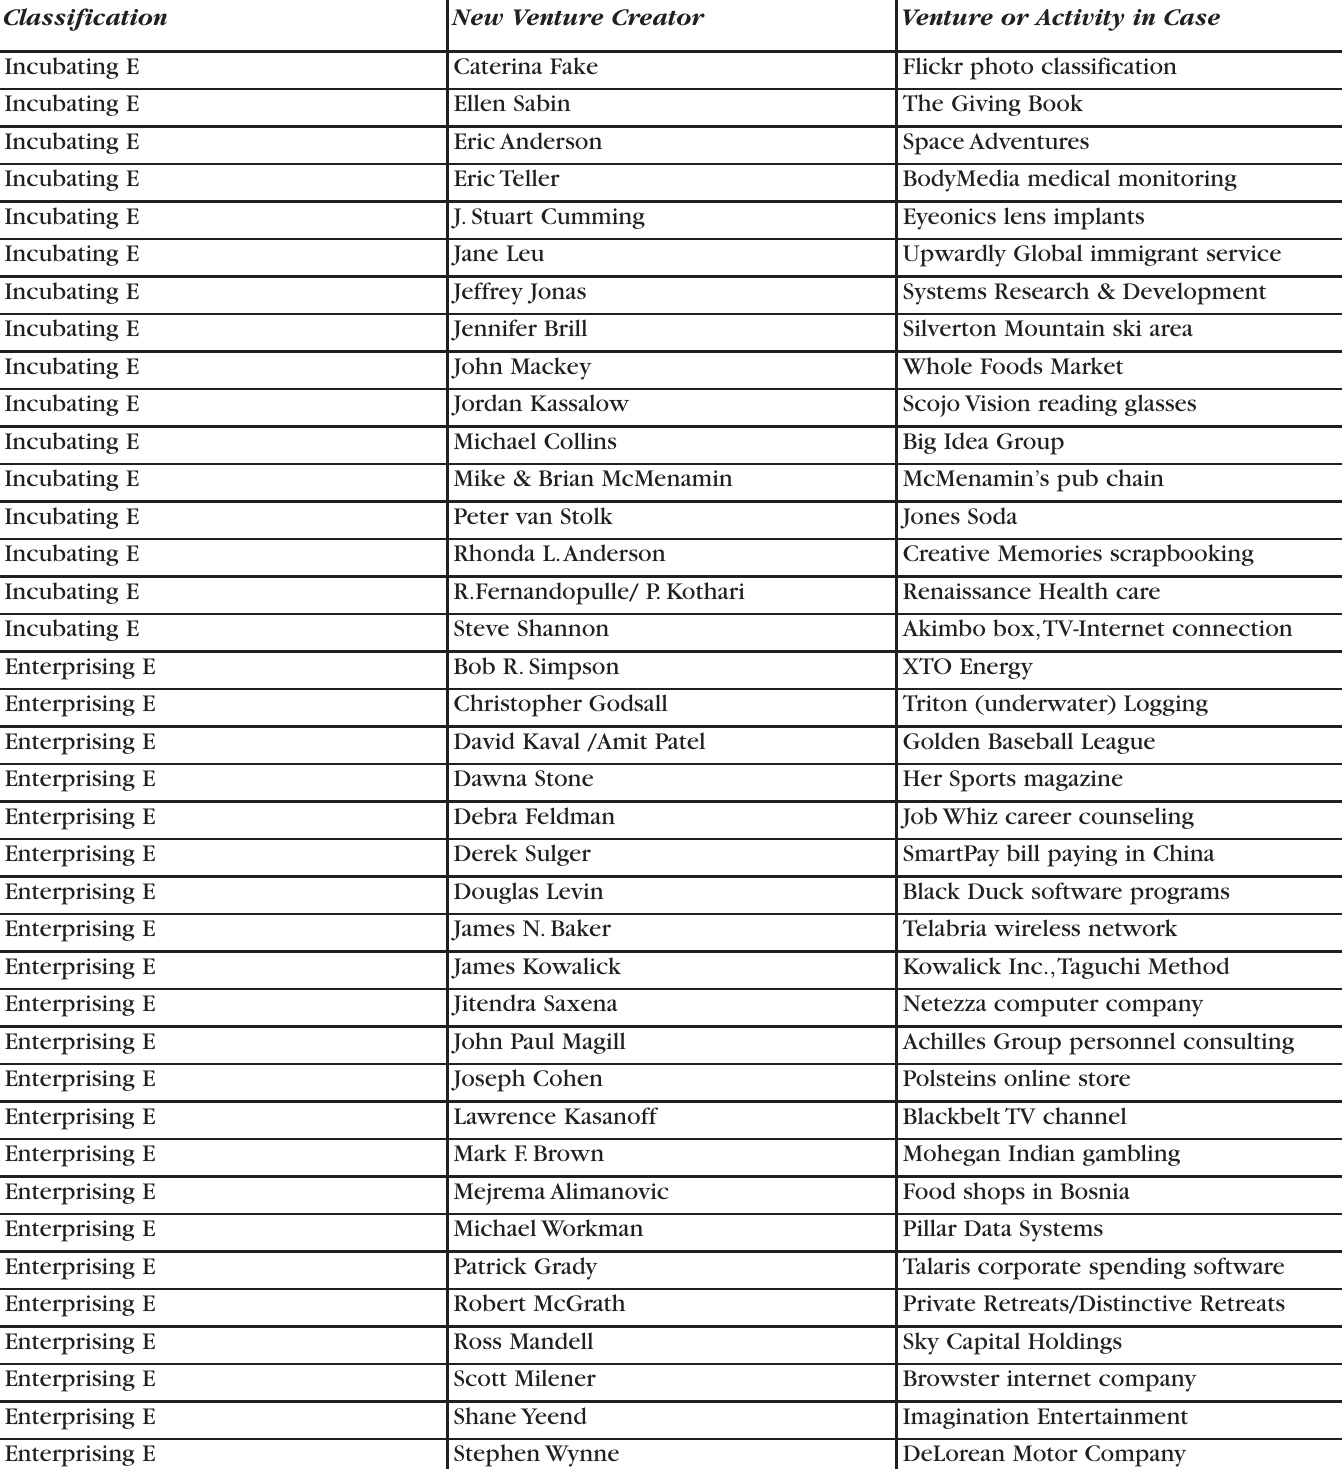
Table 2. Classification of the